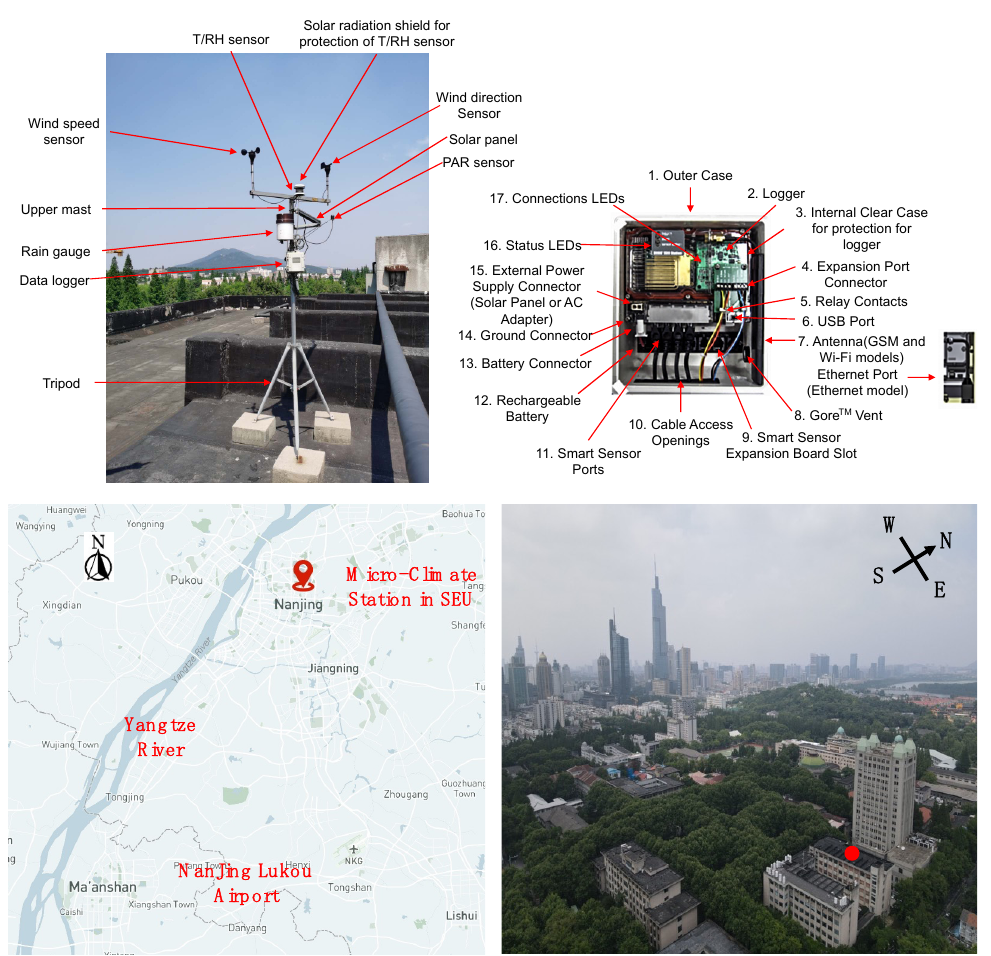
Figure 2. The picture and location of micro-climate station in this study. Table 1. The basic information of sensor set used in this study.